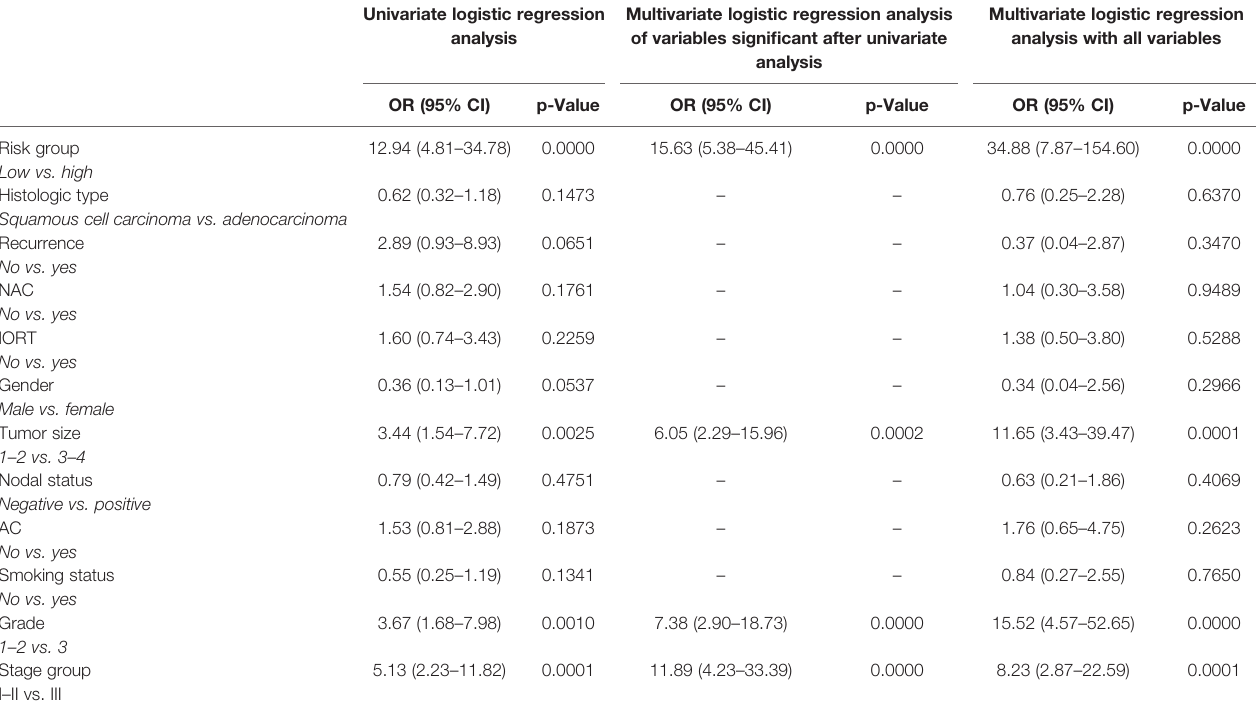
TABLE 2 | Univariate and multivariate logistic regression analyses of factors associated with distant metastasis in NSCLC patients.